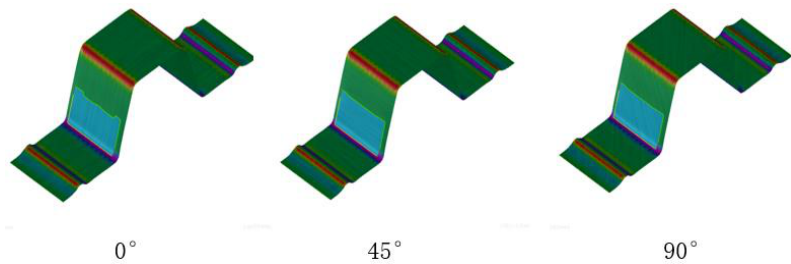
Figure 25. Skid line display at different rolling direction.